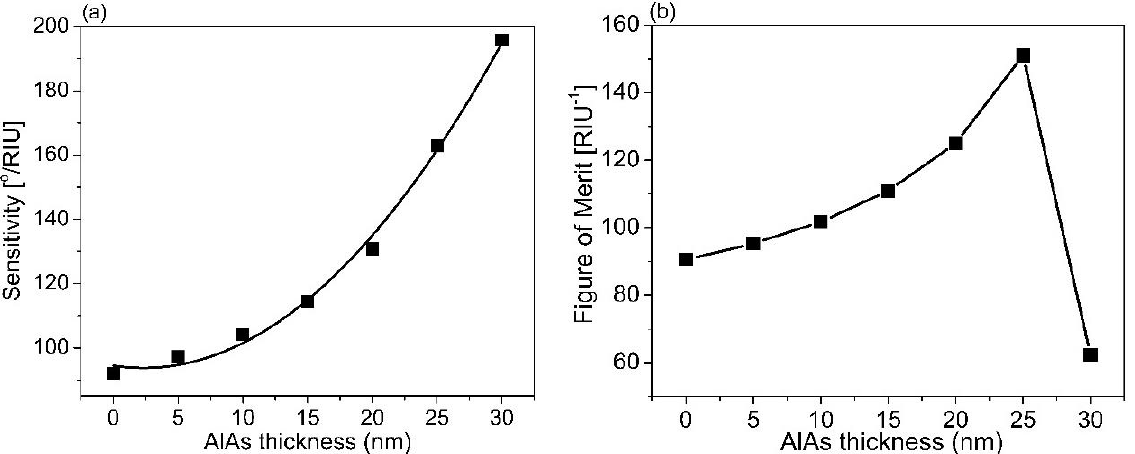
Figure 6. ( a ) The dependence of sensor sensitivity versus the thickness of the AlAs layer; ( b ) The comparison of the FOM of the sensor performance for various AlAs thicknesses.